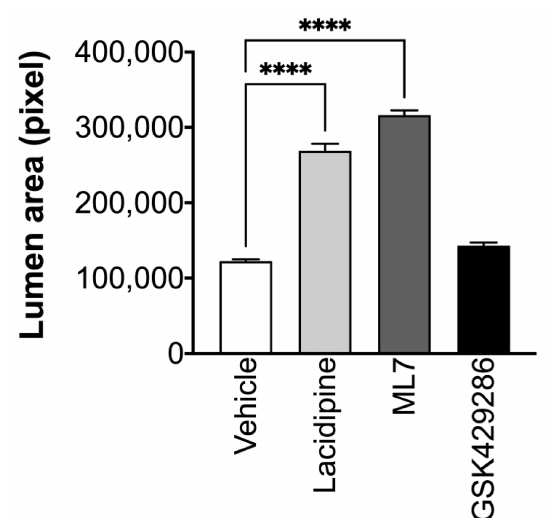
Figure 6. Lacidipine induces lumen formation through MLCK inhibition rather than ROCK in- hibition. Representative fluorescence images of ML7, a myosin light chain kinase inhibitor (1 μ M), which enhances the lumen formation with a similar phenotype of Lacidipine. However, the ROCK inhibitor (GSK429286, 5 μ M) did not enhance the lumen formation. n = 4 per condition, data are expressed as mean ± S.E.M, one-way ANOVA followed by Bonferroni’s post hoc test, **** p < 0.0001 as compared to vehicle; scale bar = 100 μ m.